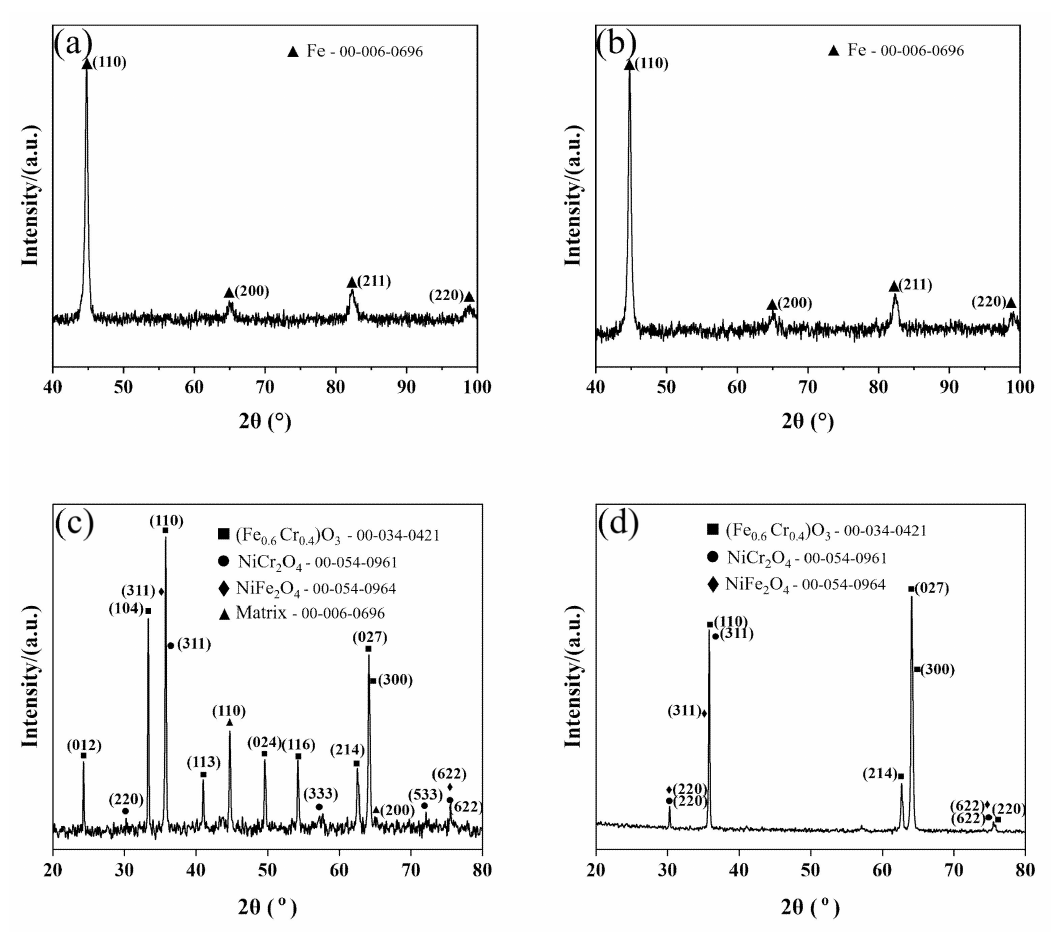
Figure 4. ( a , b ) XRD patterns of unoxidized 3Cr3Mo2NiW and 3CrNi3Mo steel; ( c , d ) XRD patterns of 3Cr3Mo2NiW and 3CrNi3Mo steels after 10 h of